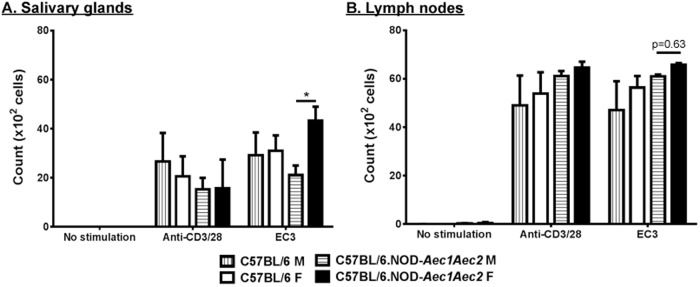
Antigen-specific hyperproliferation of Th17 cells in female C57BL/6.NOD-Aec1Aec2. CFDA proliferation assay of salivary gland lymphocytes (A) and cervical lymph nodes (B) utilizing an antigen-non-specific manner (anti-CD3/anti-CD28), an antigen-specific activation (EC3, the third cytoplasmic loop peptide of M3R) and media alone as no stimulation for male and female C57BL/6 and C57BL/6.NOD-Aec1Aec2. Lymphocytes were incubated with CFDA prior to stimulation conditions (4 days), followed by flow cytometry and analysis on FlowJo software. Th17 cells were gated for live CD3+CD4+IL-17+. Statistically significant results were calculated with two-way ANOVA on male (n=5) and female (n=5) C57BL/6, and male (n=5) and female (n=3) C57BL/6.NOD-Aec1/2 female. Error bars indicates s.e.m. with ****P<0.00001.